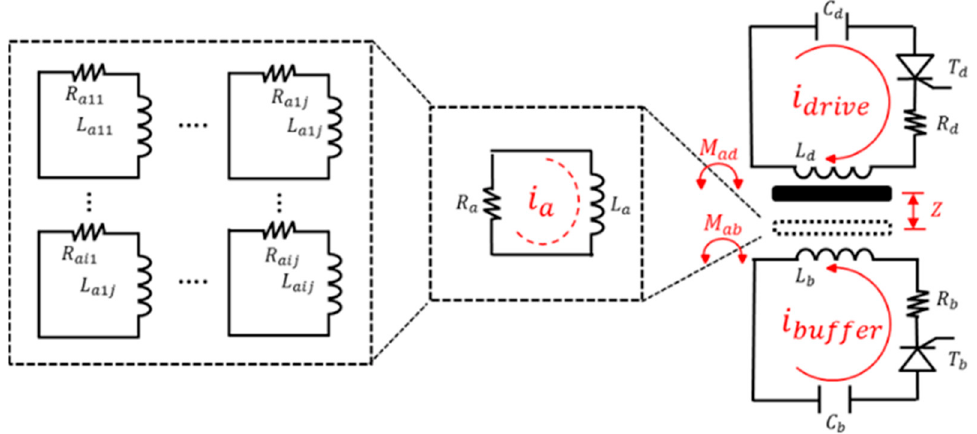
Figure A1. ECM schematic of the TCA drive, buffer, and armature circuits.